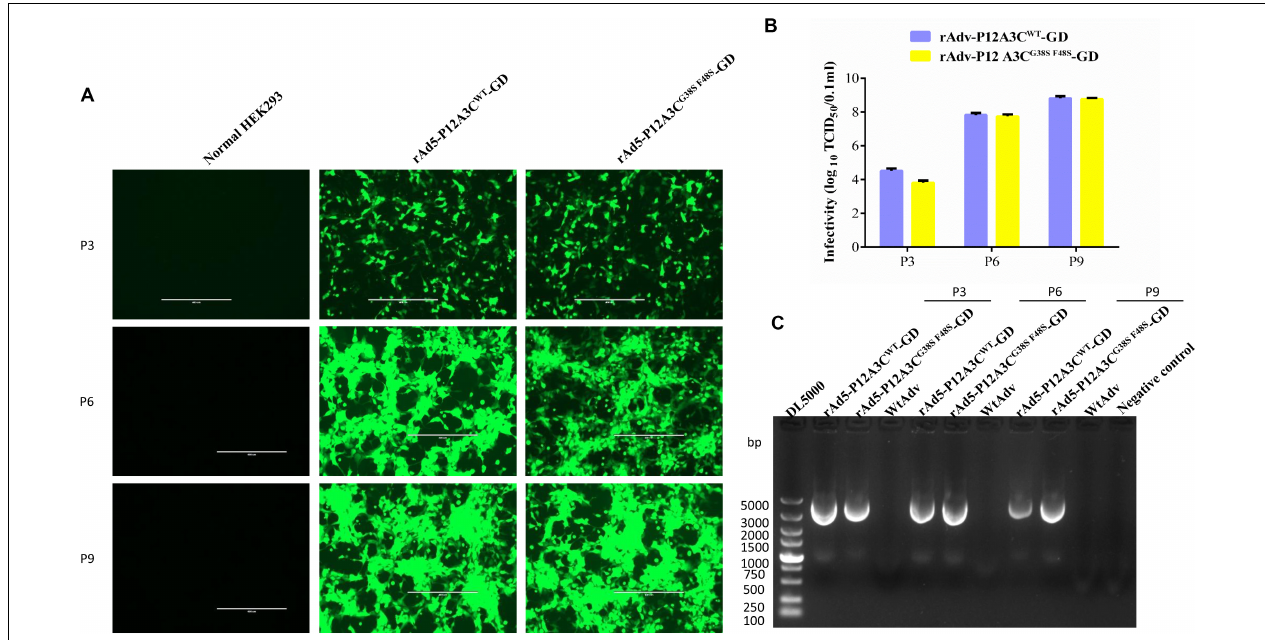
FIGURE 2 | Construction and identification of the recombinant adenoviruses. (A) CPE and green fluorescence observed in different passages (P3, P6, and P9). (B) Adenoviral titers in different passages (P3, P6, and P9) were monitored with a TCID 50 assay. Results are presented as means ± standard deviations (SD), n = 3.